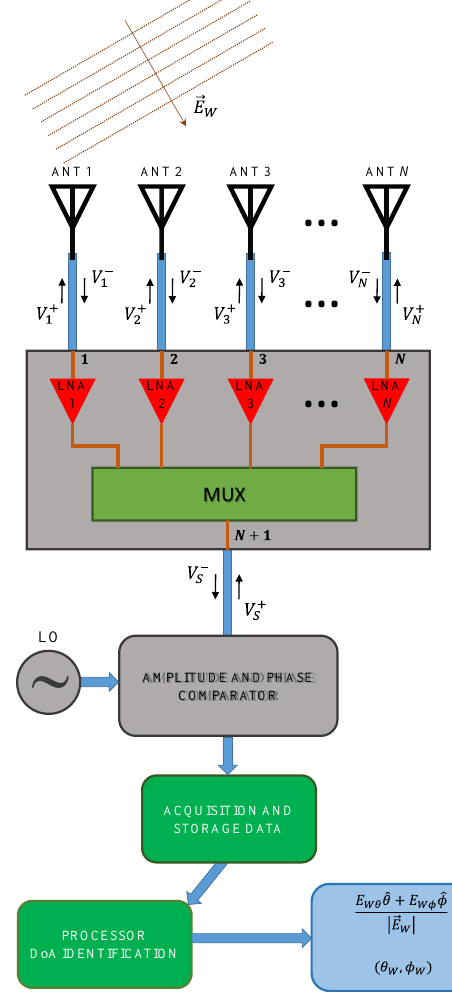
Figure 1. Direction finding system architecture.